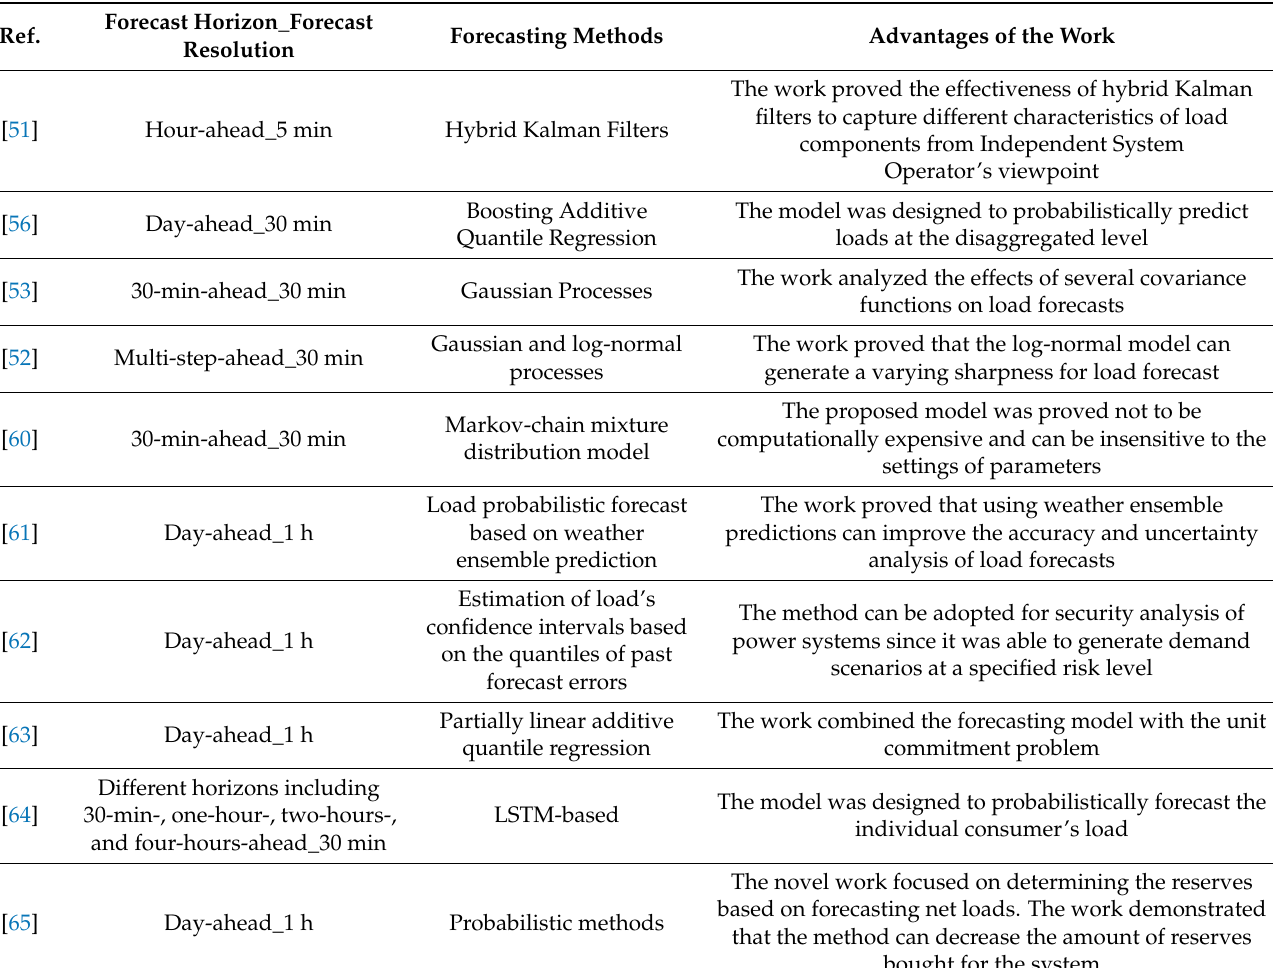
Table 4. An overview of selected papers developing probabilistic forecasting models for electric- ity